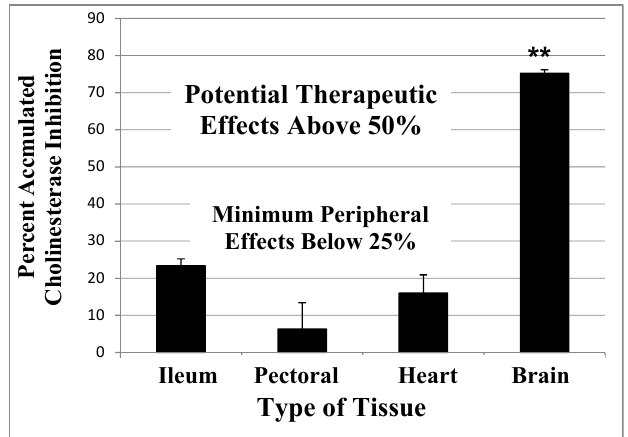
Figure 3. Accumulated AChE inhibition in four rat tissues after three weeks of repeated doses of 0.3 mg/kg MSF (IM) given three times per week to approximate the smaller daily dose shown in Figure 2. The animals were sacrificed 24 h after the last injection and smooth muscle (ileum), skeletal muscle (pectoral), cardiac muscle (heart), and whole brain were assayed for AChE inhibition, compared to untreated controls. CNS is significantly more inhibited than peripheral tissues (** p < 0.01), but peripheral tissues are not different from each other. Error bars show SEM [128]. (From British Journal of Clinical Pharmacology , 75 , A Randomized Phase 1 Study of Methanesulfonyl Fluoride, an Irreversible Cholinesterase Inhibitor, for the Treatment of Alzheimer’s Disease, 1231–1239 (2013), with permission Wiley Press).